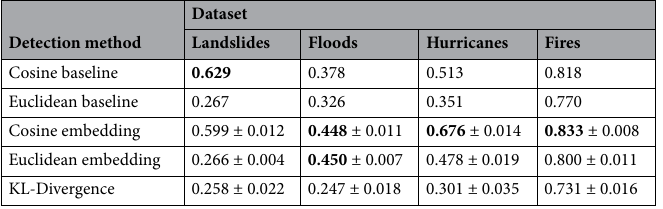
Table 3. AUPRC for baseline and VAE methods with time window k = 1 (averaged over 5 runs).